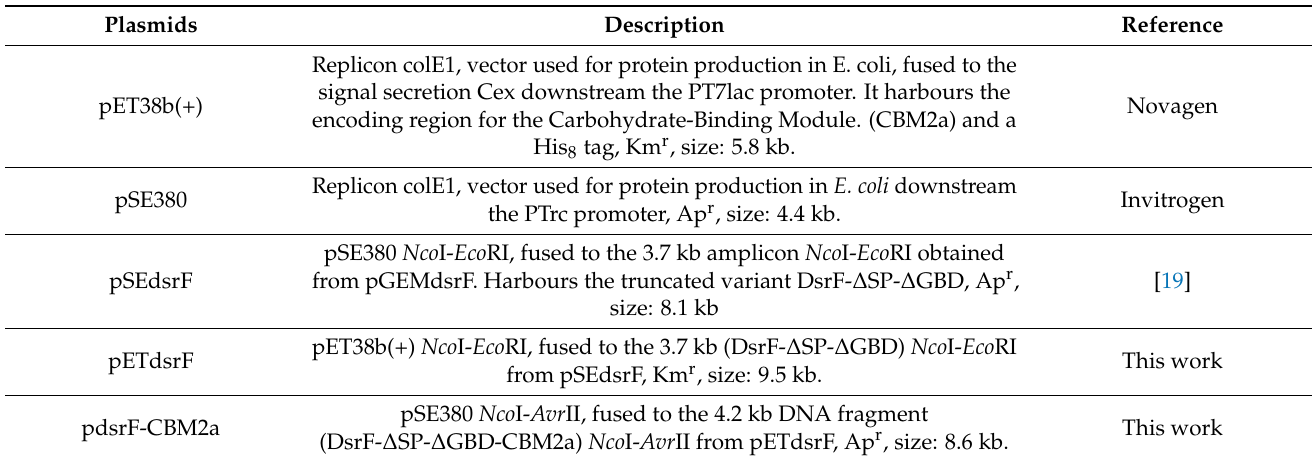
Table 1. Plasmids used in this